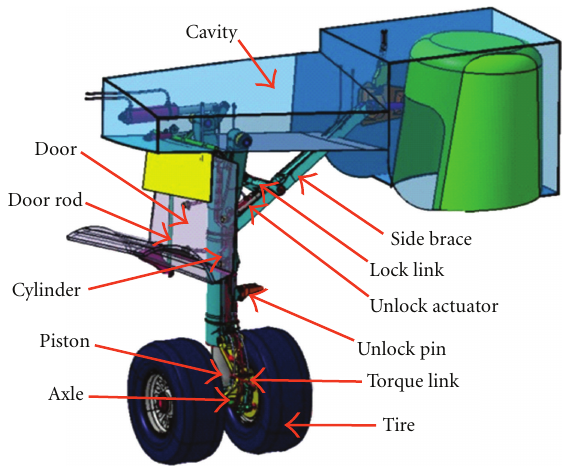
Figure 1: JAXA’s two-wheel main landing gear model (LEG model)